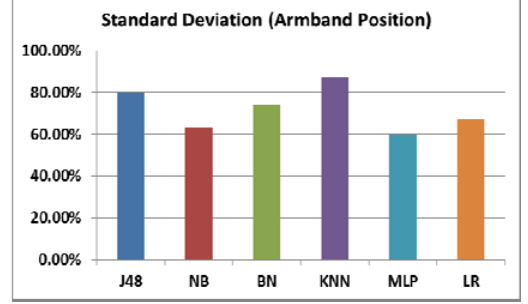
Fig. 6. Comparison of classification algorithms